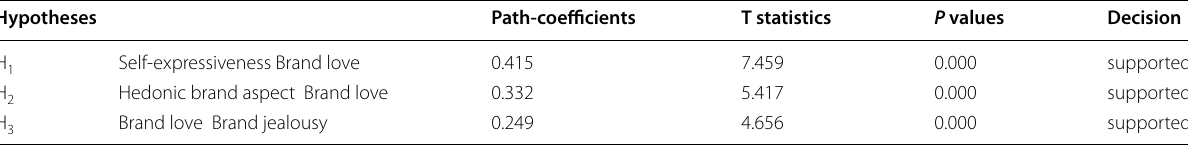
Table 4 Results of hypotheses testing Hypotheses